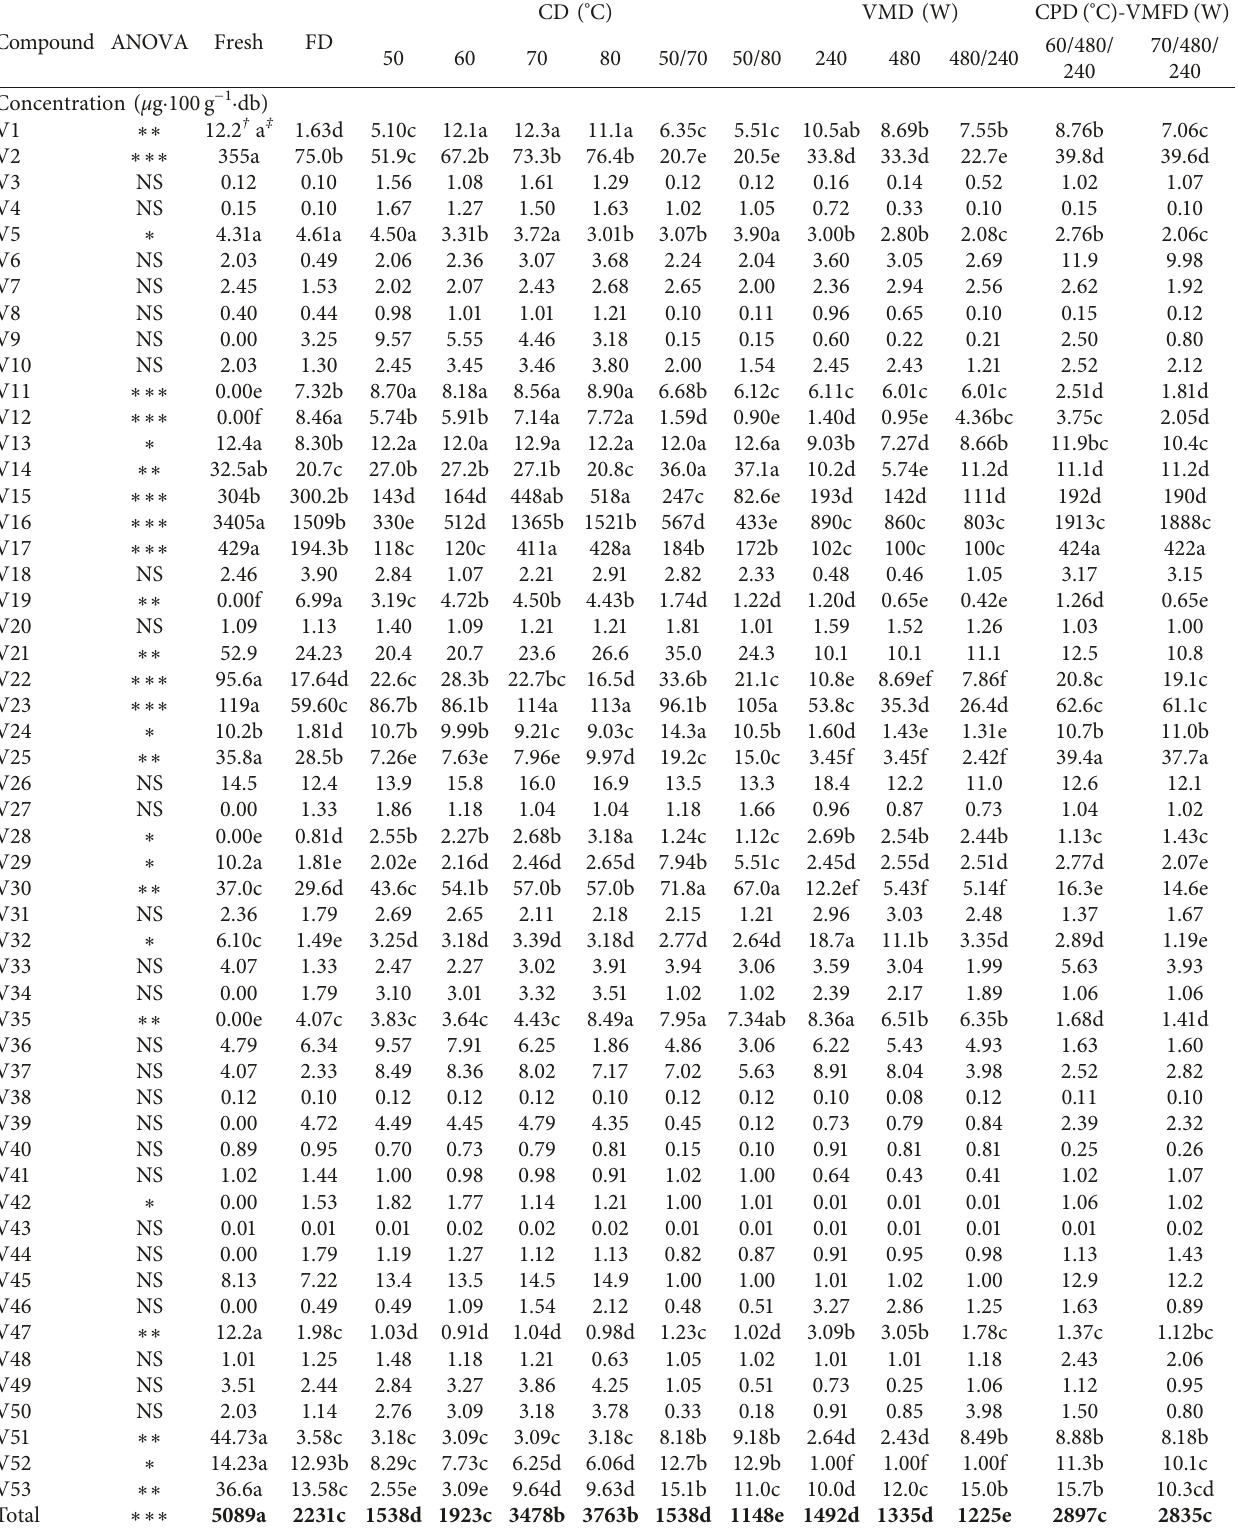
Table 3: Content of volatile compounds ( µ g 100g − 1 db, dry basis) in fresh, freeze-, convective-, vacuum microwave-, and CPD-VMFD- dried cepe